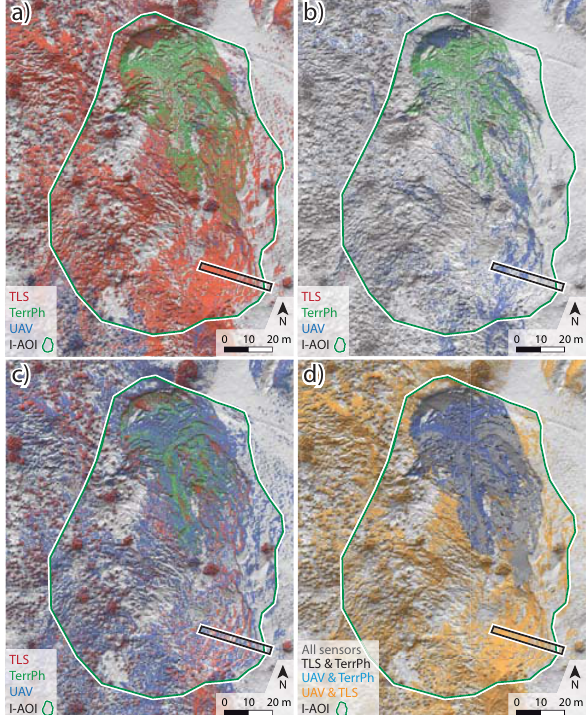
Figure 10. Spatial distribution of the integration decisions for the data of 2017 ( s v = 0 . 2 m) for the applied integration rules ’maximum geometric curvature’ (a), ’maximum planarity’ (b), ’minimum elevation’ (c), and ’sensor correspondence’